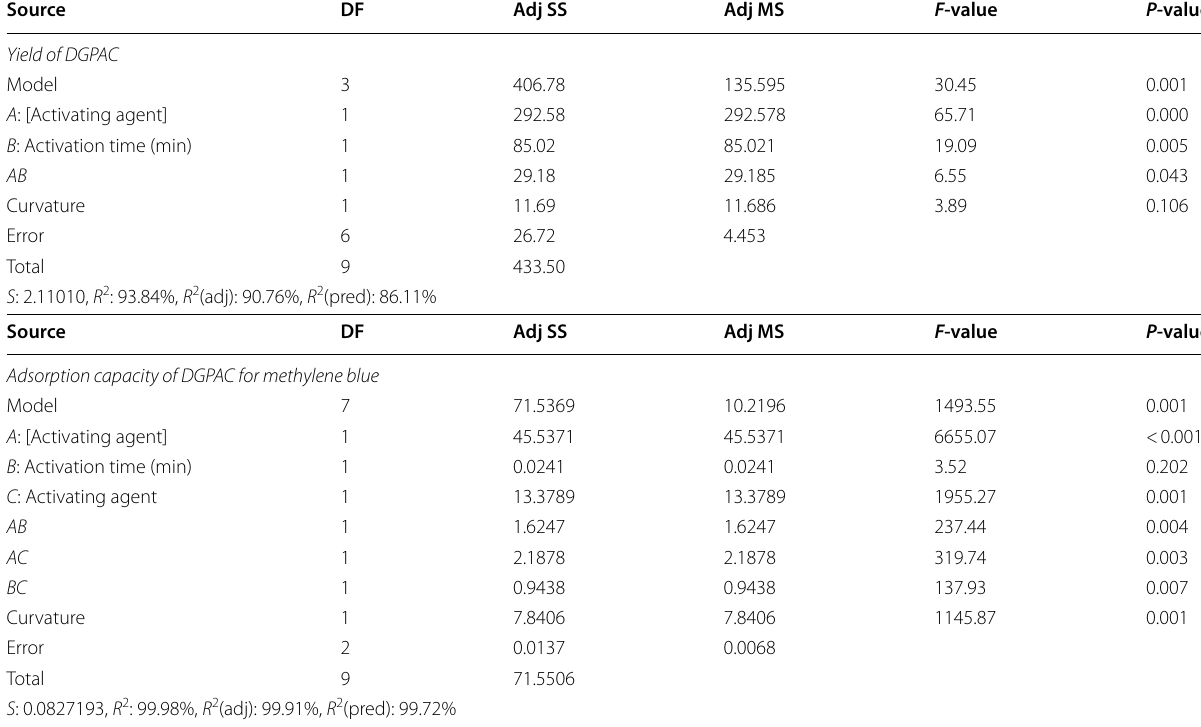
DF, degrees of freedom; Adj.SS, adjusted sum of squares; Adj MS, adjusted mean of squares; F -value, Fisher’s test value; P -value, probability value